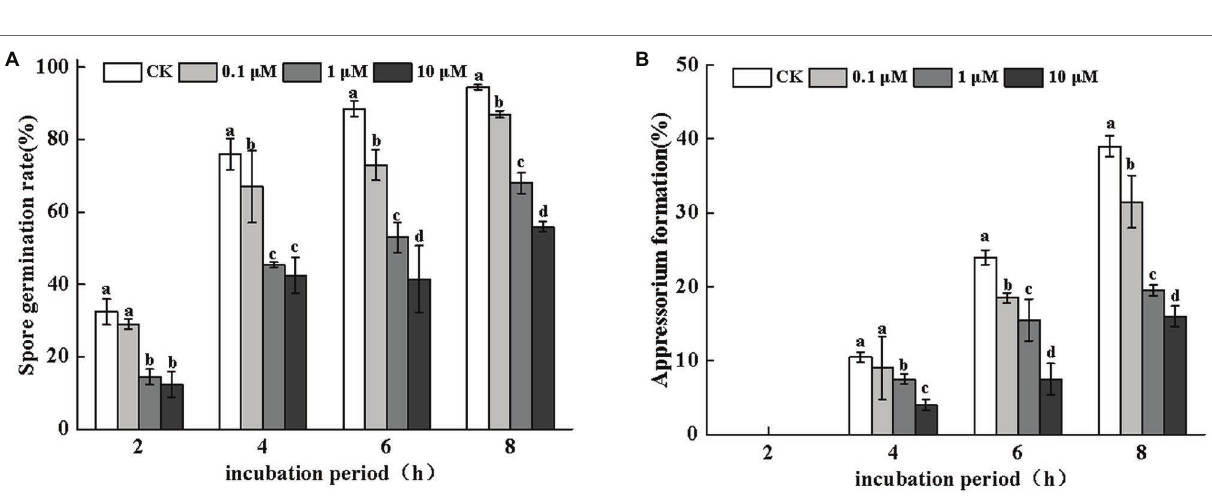
FIGURE 3 | Effects of neomycin on spore germination (A) and appressorium formation (B) in A. alternata . Conidial suspensions treated with a range of concentrations of neomycin were plated onto the hydrophobic surface of Gelbond. Vertical lines indicate standard error (± SE ) of the means. Different letters indicate significant differences ( p < 0.05).